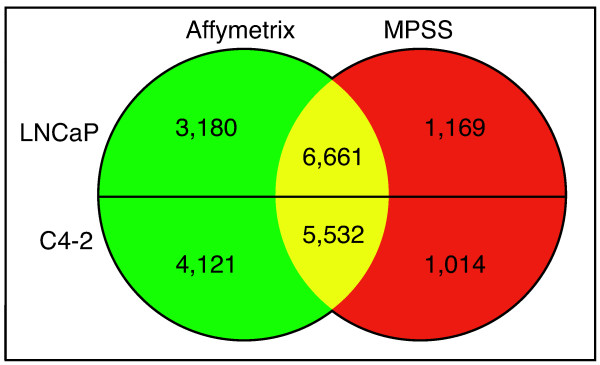
Merged Affymetrix and MPSS transcriptome profiles. Number of genes detected by Affymetrix and MPSS expression profiling of LNCaP (top) and C4-2 (bottom) cell lines. The number of genes detected by both platforms is listed in the yellow area, genes unique to Affymetrix are in the green area, and genes unique to MPSS are in the red area. Thousands of genes were only detected by one technology in each respective cell line.